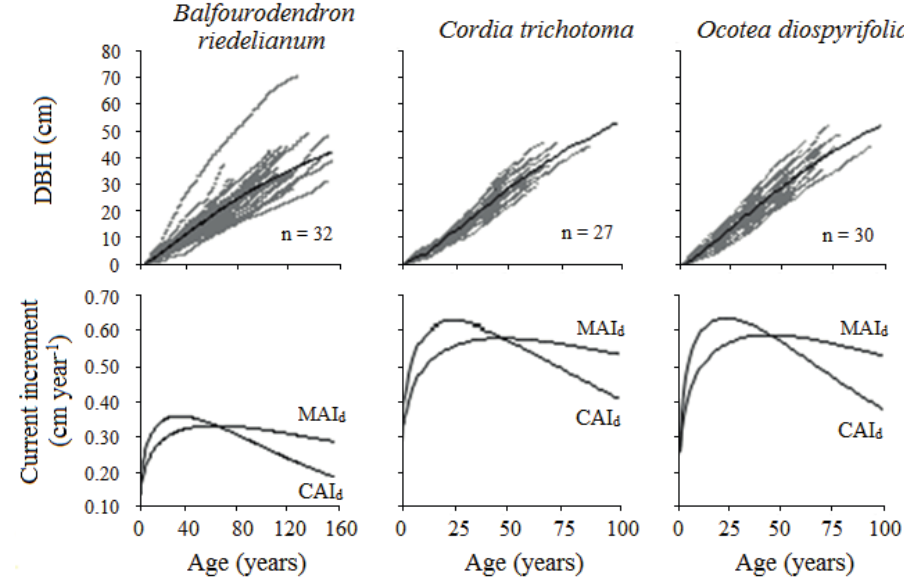
Figure 3 - Individual diametric growth curves and mean curves fitted by growth models (black line), current annual increment in diameter (CAId) and mean annual increment in diameter (MAId) to Balfourodendron riedelianum , Cordia trichotoma and Ocotea diospyrifolia in the Iguaçu National